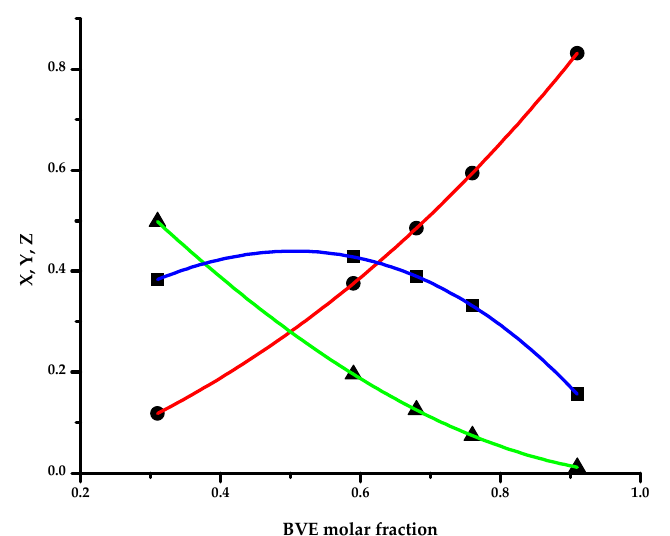
Figure 2. Dyad monomer sequence distributions X = M BVE-BVE ( (cid:8) ), Y = M CEVE-CEVE ( (cid:78) ) and Z = M BVE-CEVE ( (cid:4) ) of the statistical copolymers.